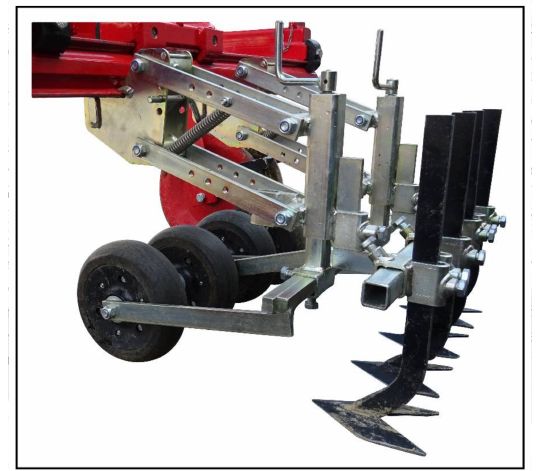
Figure 1. Overview of the parallelogram system: two K.U.L.T. DUO-parallelograms with no-till sweeps for 150 mm row